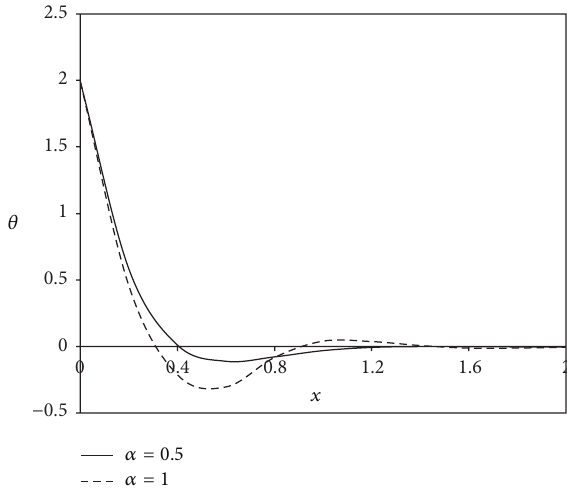
Figure 2: Temperature distribution 𝜃 for different values of 𝛼 at 𝑡 = 0.1 .